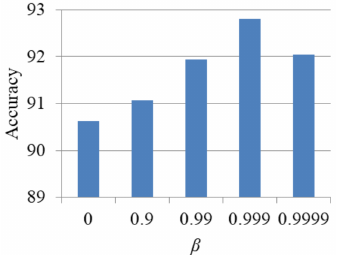
Figure 14. Hyper-parameter β impact on classification accuracy.